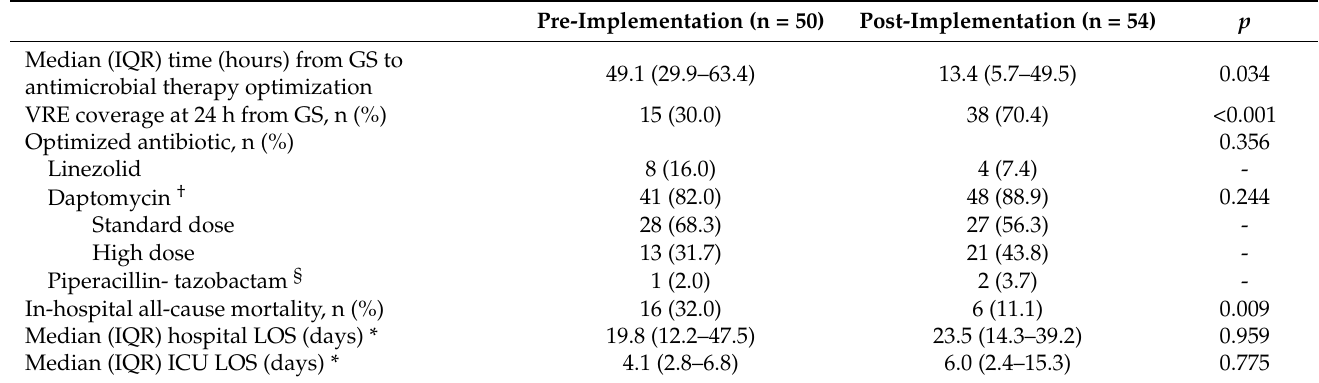
Table 2. Outcomes by implementation group.